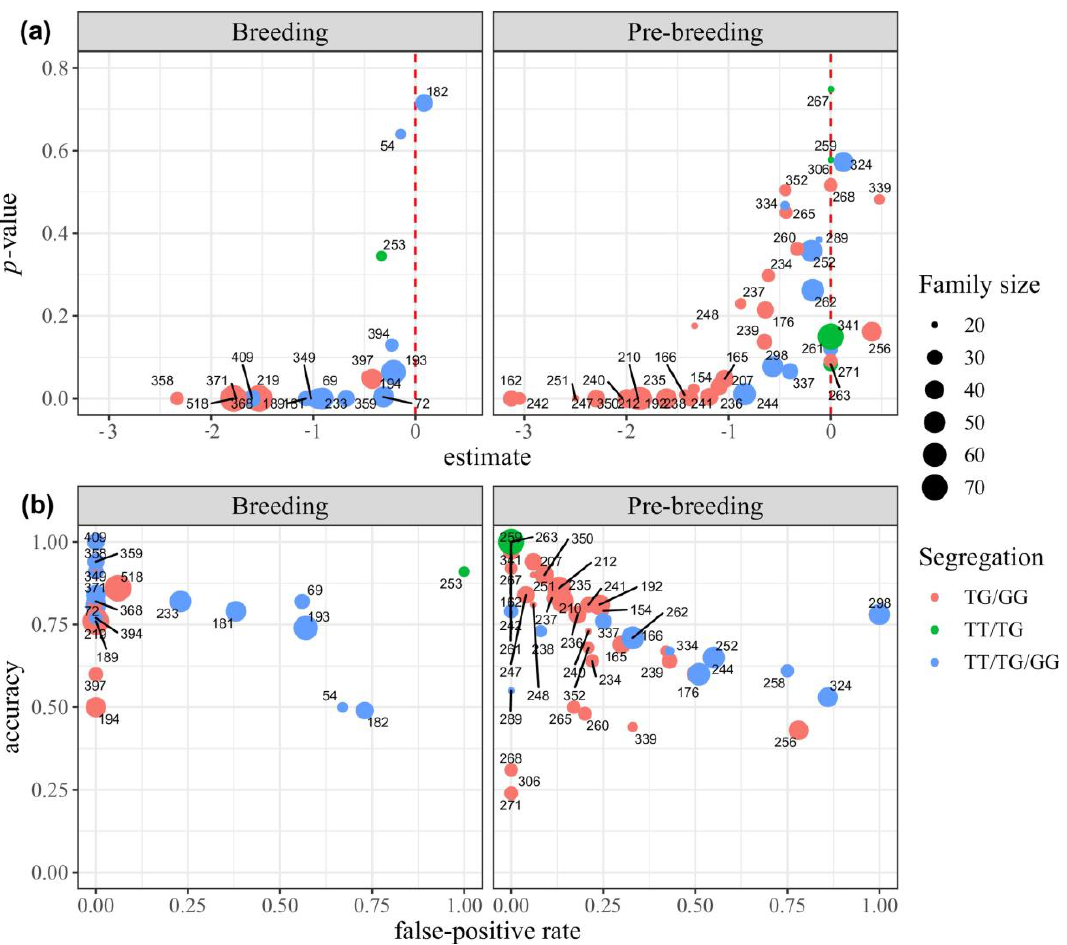
Figure 5. Within-family performance metrics of marker S12_7926132 assessed using the SN data: ( a ) allelic substitution effects and p -values; ( b ) accuracy versus false-positive rate. Only families with 20 or more individuals were